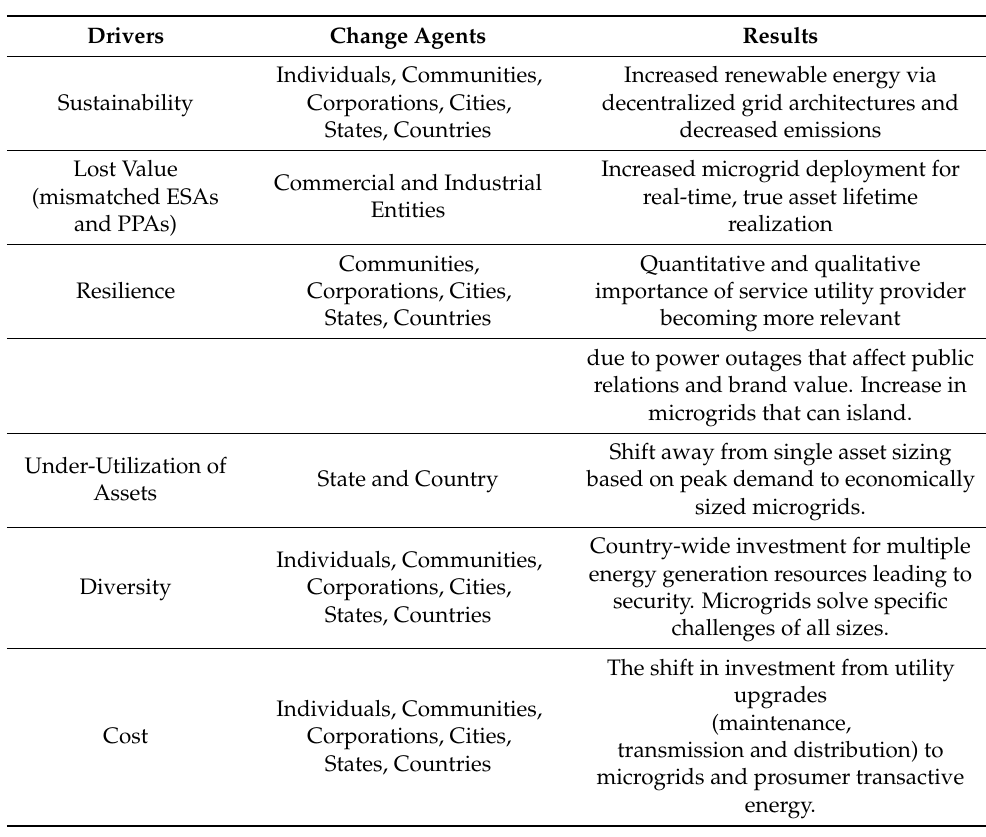
Table 3. Drivers and impacts of microgrid adoption in the energy